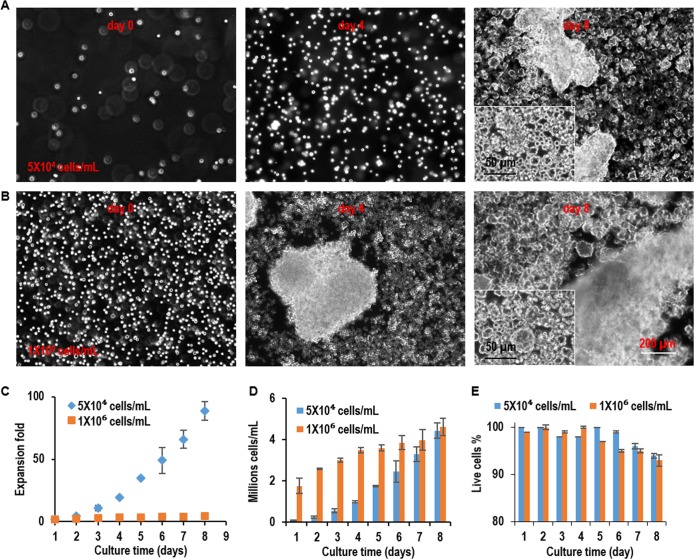
3D suspension culture of L-Wnt-3a-cells.L-Wnt-3a-cells were suspended in the low-attachment 6-well plate that was placed on a shaker at 60 rotations per minute (rpm) at low density (5x104 cells/mL) and high density (1x106 cells/mL). (A, B) Phase images of cells on day 0, day 4 and day 8. (C, D, E) The expansion fold, volumetric yield, and cell viability from day 1 to day 8 of the culture. Error bars represent the standard deviation (n = 3). #: P<0.05.